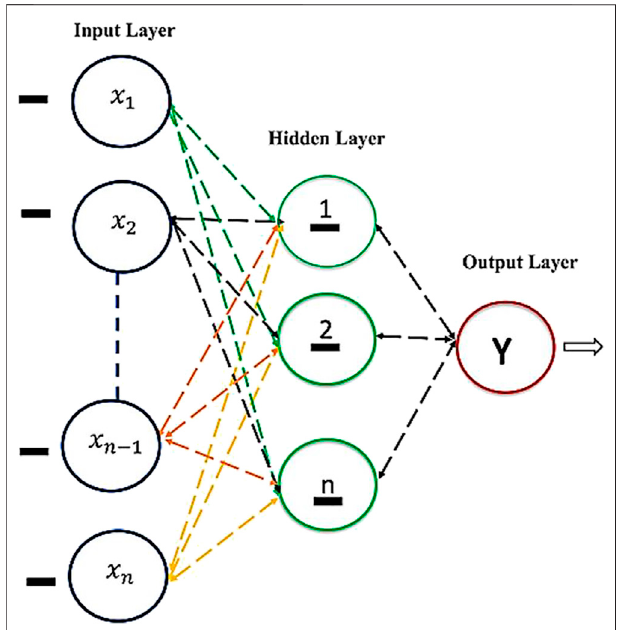
FIGURE 2 | Structure architecture of an MLP neural